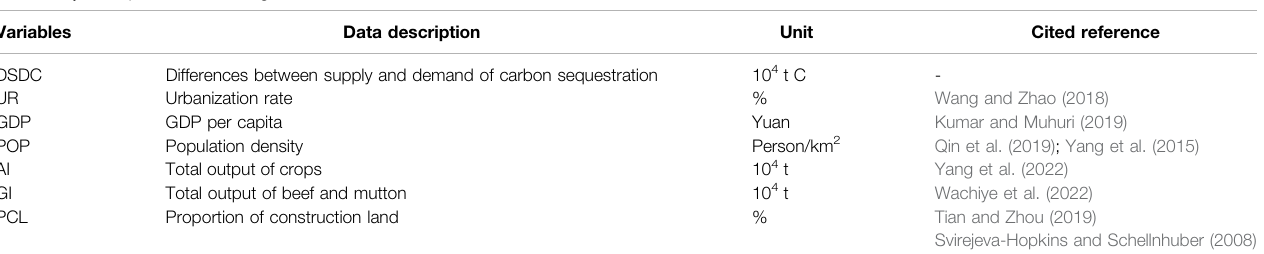
TABLE 4 | Description of the driving force